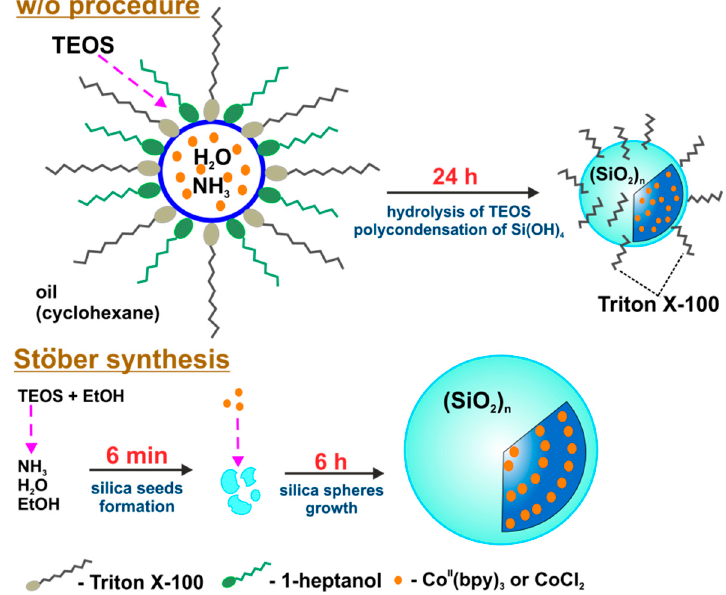
Scheme 1. Schematic representation of different techniques for synthesis of Co II @SiO 2 .